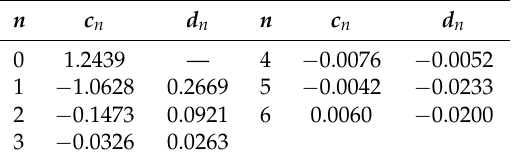
Table 2. The coefficients of Equation (2).